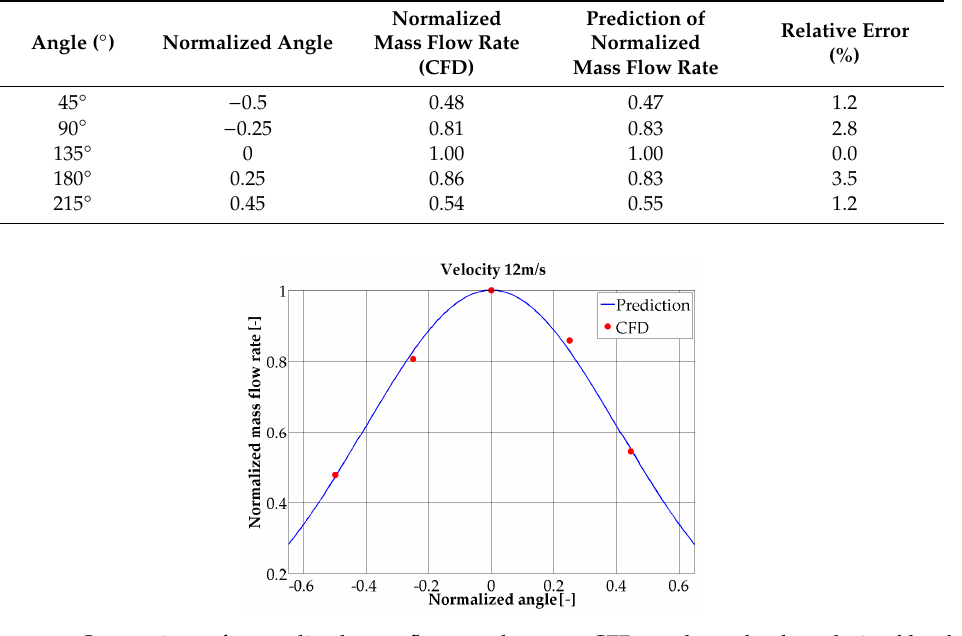
Figure 19. Comparison of normalized mass flow rate between CFD results and values derived by the function for 12 m/s wind speed.